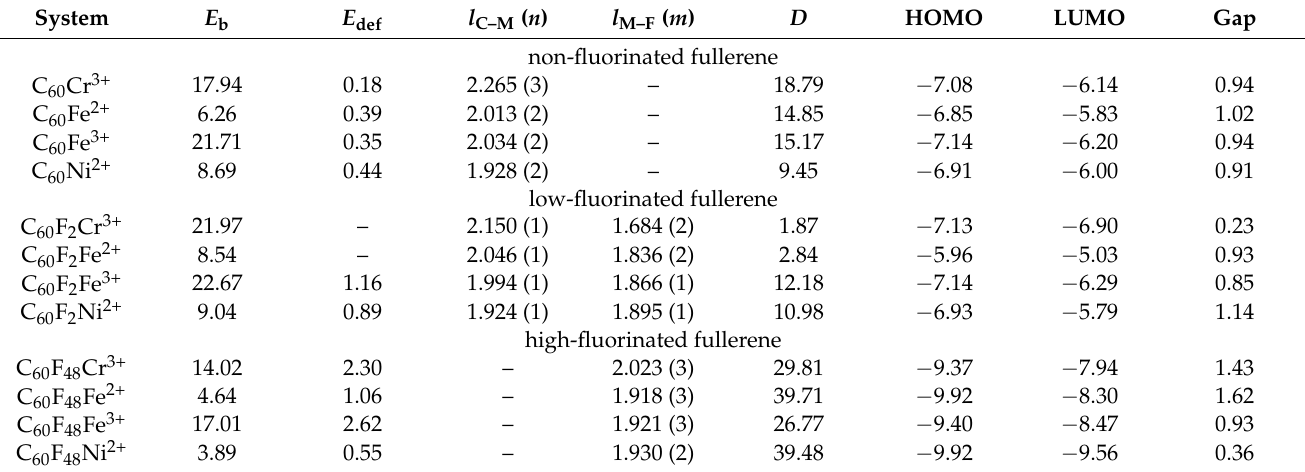
Table 2. Calculated geometric and energetic characteristics of metal-decorated pristine and fluori- nated fullerenes. Binding energy E b (eV), fullerene deformation energy E def (eV), mean length of carbon-ion bonds l C–M (Å) and the number of such bonds n (dimensionless), mean length of fluorine- ion bonds l M–F (Å) and the number of such bonds m (dimensionless), dipole moments D (Debye), frontier molecular orbitals HOMO and LUMO (eV) and HOMO–LUMO gaps (eV) are presented.